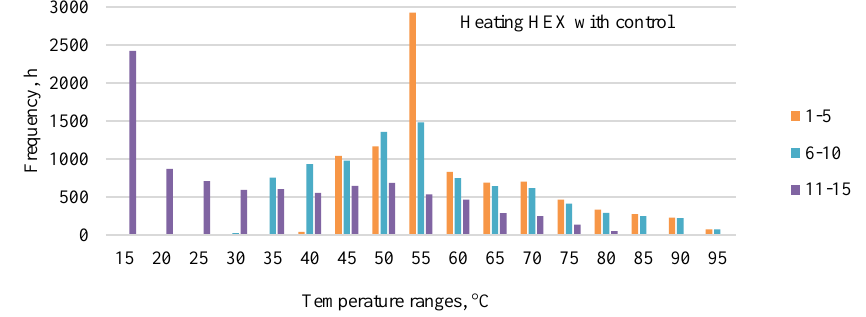
Fig. 4. Hourly frequency of temperature ranges with heating HEX and dead band control for annual simulation. In Fig. 3 the temperature of 15 °C has the highest frequency in all levels of the tank and higher temperatures are reached more often during summer months. In comparison, if auxiliary heat is added in the top of the tank (Fig. 4), 55 °C has the highest frequency in the top portion of the tank. Therefore, the chosen design is with HEX aux and an external heat source with constant power of 2 kW, circulation flow rate of 200 kg/h and controlled by water temperature sensor at the level of bottom of HEX aux with the use of dead bands. The upper dead band is 10 °C and the lower dead band is 2 °C, which means, that the auxiliary heater is turned on if the temperature falls below 53 °C and turned off when it heats above 65